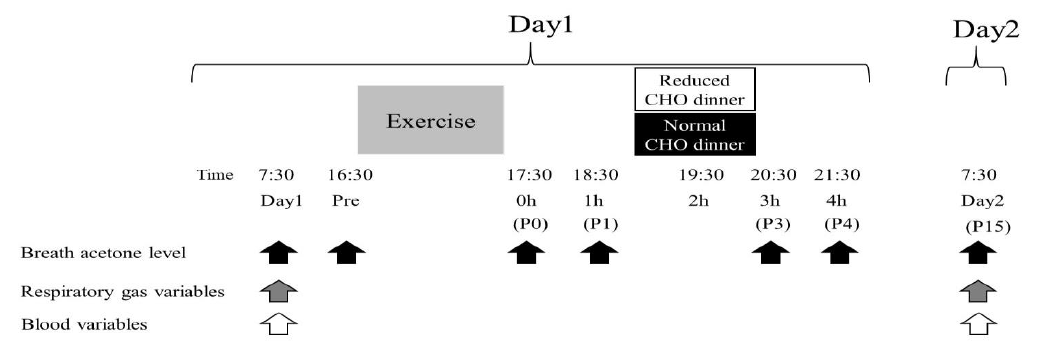
Figure 1. Experimental overview.